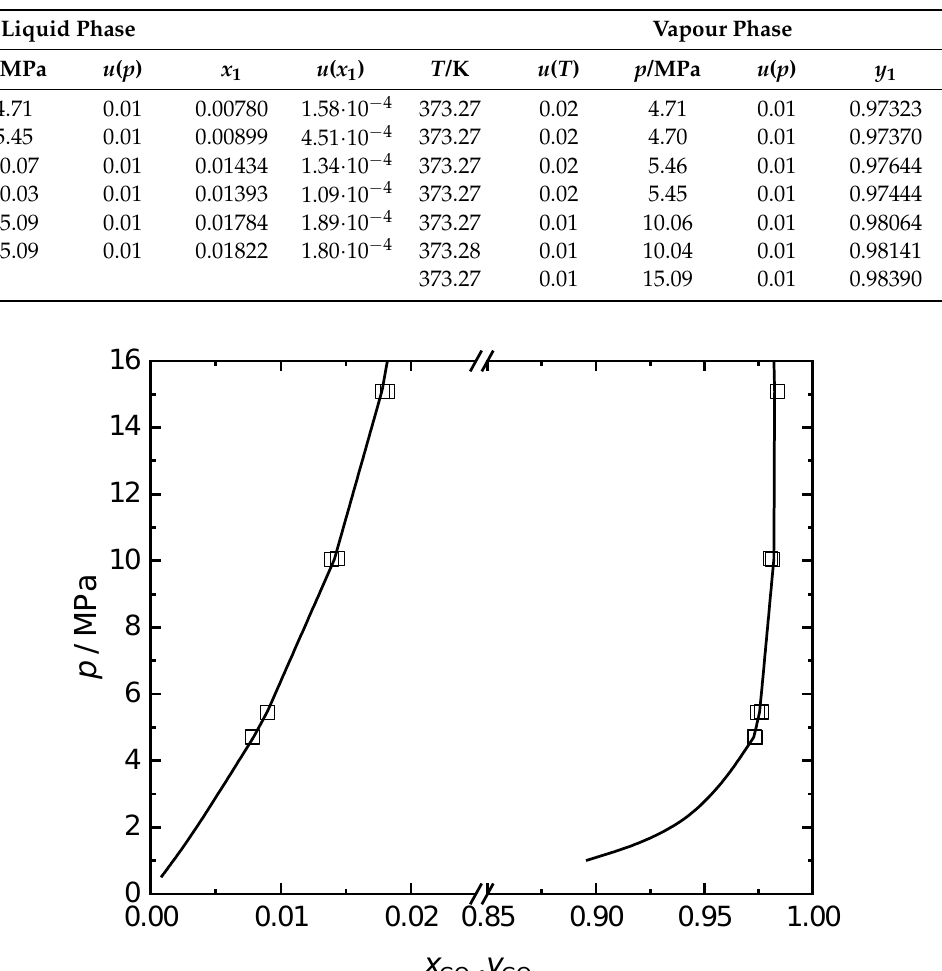
Table 6. Experimental vapour – liquid equilibrium data for the CO 2 (1) + H 2 O(2) systems at 373 K and up to 15 MPa. x represents mole fraction in the liquid phase, y denotes mole fraction in the gas phase and u denotes standard uncertainty.